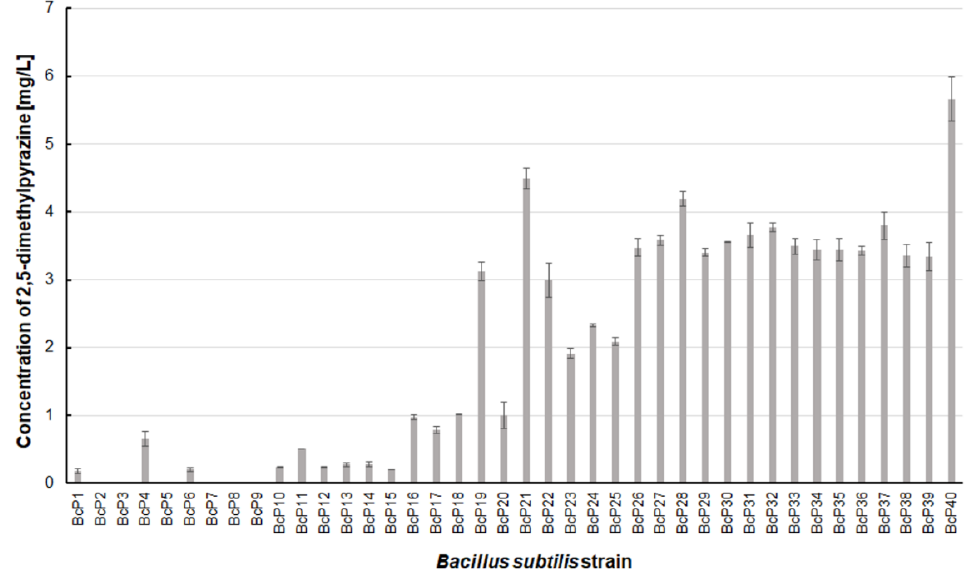
Figure 6. The 2,5-dimethylpyrazine biosynthesis by B. subtilis strains. However, as many as 20 isolated bacterial strains (BcP19, BcP21-22, BcP24-40) were able to produce 2,5-dimethylpyrazine at concentrations greater than 2 mg/L (Figure 6). The strains (BcP1, BcP4) with the highest production capacity of 2-methylpyrazine, 2,3- dimethylpyrazine, and 2,6-dimethylpyrazine produced 2,5-dimethylpyrazine only at a concentration of 0.178 ± 0.037 mg/L and 0.653 ± 0.109 mg/L, respectively. Only five of the analyzed strains (BcP3, BcP5, BcP7-9) did not produce any 2,5-dimethylpyrazine (Figure 6). The BcP21 and BcP40 strains were also the best 2,3,5-trimethylpyrazine producing strains. They produced 2,3,5-trimethylpyrazine at concentrations greater than 45 mg/L, nearly four times that of the other 26 strains (BcP10-15, BcP19-20, BcP22-39), which pro- duced ca. 10 mg of this compound per liter (Figure 7). In contrast, the BcP1 – 4 strains did not biosynthesize 2,3,5-trimethylpyrazine despite being good producers of 2-methylpyra- zine, 2,3-dimethylpyrazine, and 2,6-dimethylpyrazine (Figure 7). The highest production efficiency was observed for 2,3,5,6-tetramethylpyrazine (ca. 500 mg/L). This compound was most efficiently synthesized by the B. subtilis BcP21 strain (Figure 8). The second best producer of this compound was the BcP40 strain, but it provided ca. 270 mg of 2,3,5,6- tetramethylpyrazine per liter. No other bacterial strain isolated from fermented soybeans synthesized 2,3,5,6-tetramethylpyrazine in concentrations greater than 100 mg/L (Figure 8). Only four strains did not synthesize any 2,3,5,6-tetramethylpyrazine. Among them was the BcP4 strain, which had the highest production capacity for 2-methylpyrazine, 2,3-di- methylpyrazine, and 2,6-dimethylpyrazine (Figure 8).